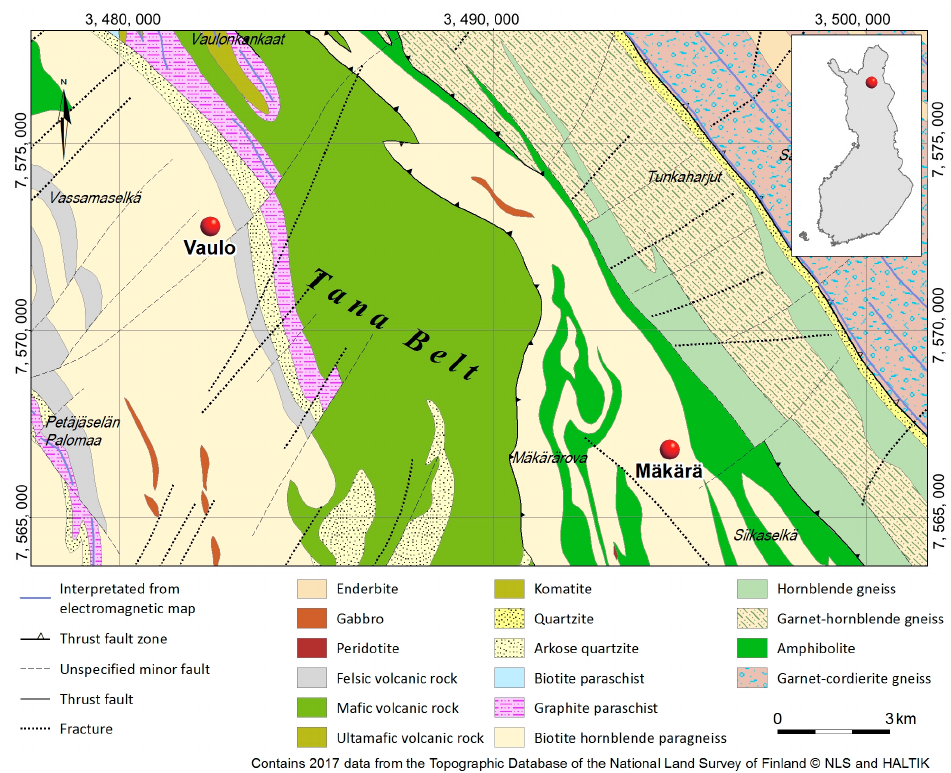
Figure 10. Geological map of the Tana belt in the area of the REE mineralization at Mäkärä and Vaulo. Modified from Salmirinne et al. [38].